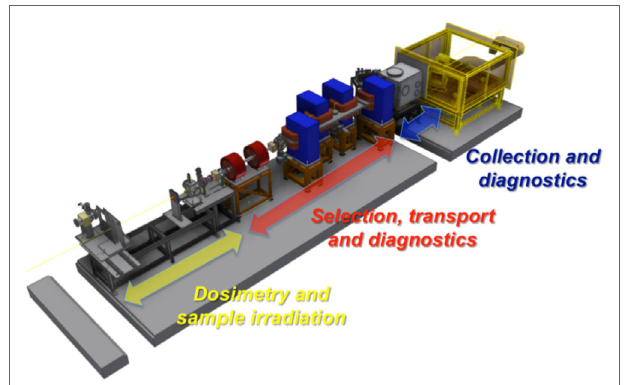
FIgURe 12 | Layout of the ELIMED beamline with the three different sections. This picture reproduced with the permission of the